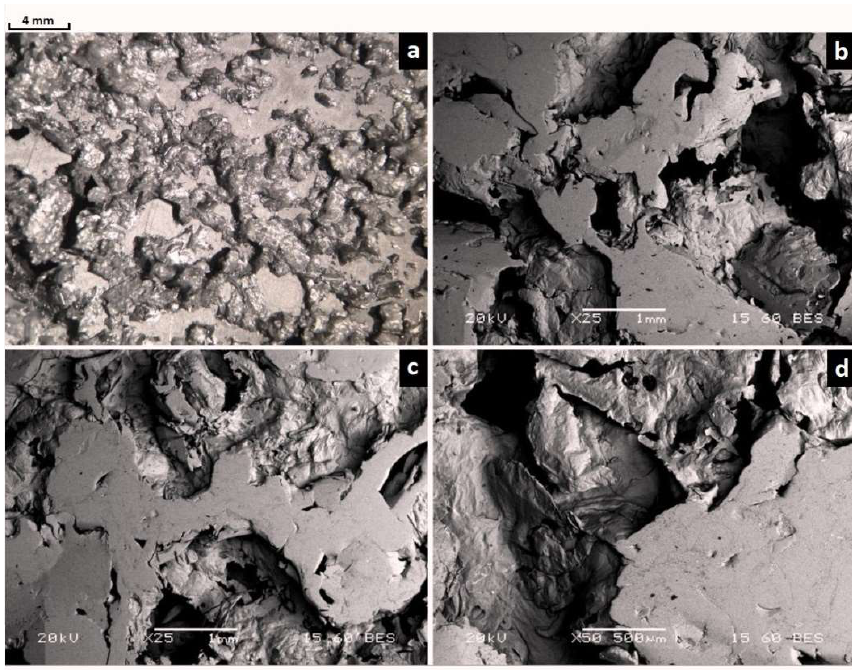
Figure 10. Microstructure of the aluminum foam samples sintered at 740 °C: ( a ) Optical stereoscopy image illustrating the irregular porous morphology, ( b – d ) scanning electron images of the interior structure of the cell wall and morphology.